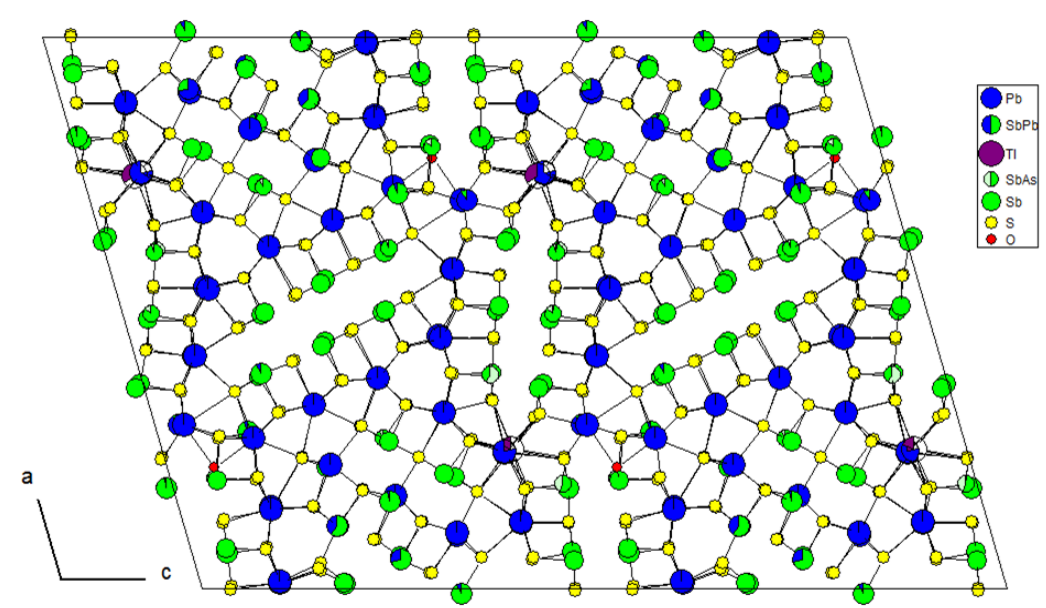
Figure 3. Unit-cell content of Tl-bearing chovanite as viewed down the b -axis.